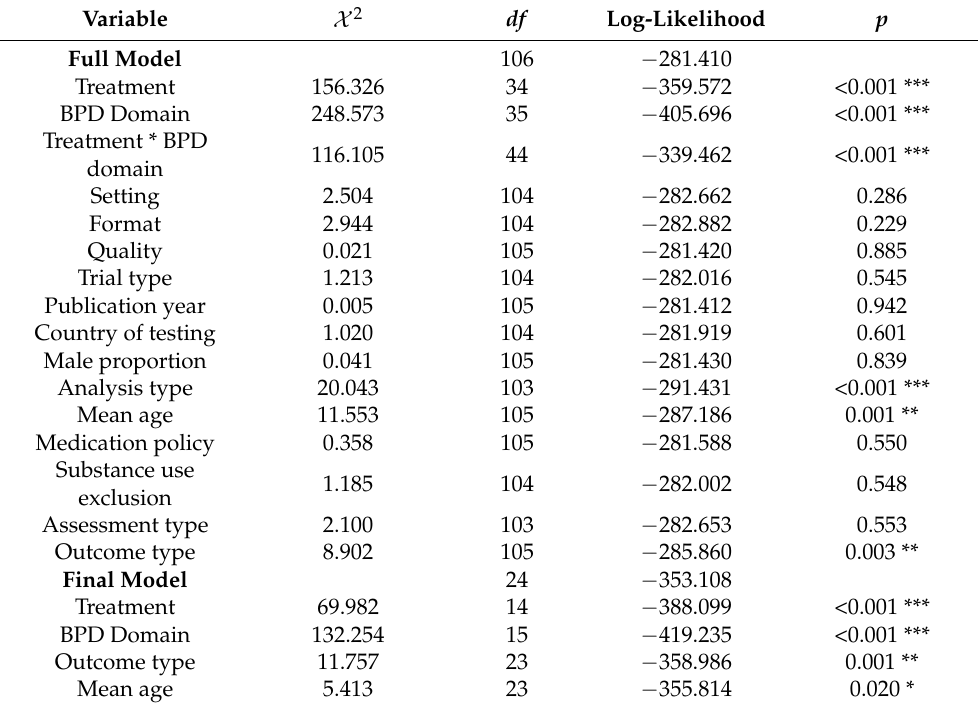
Table 1. Chi Square Tests of all the Predictors in the Full and Final Model of the Transformed Effect